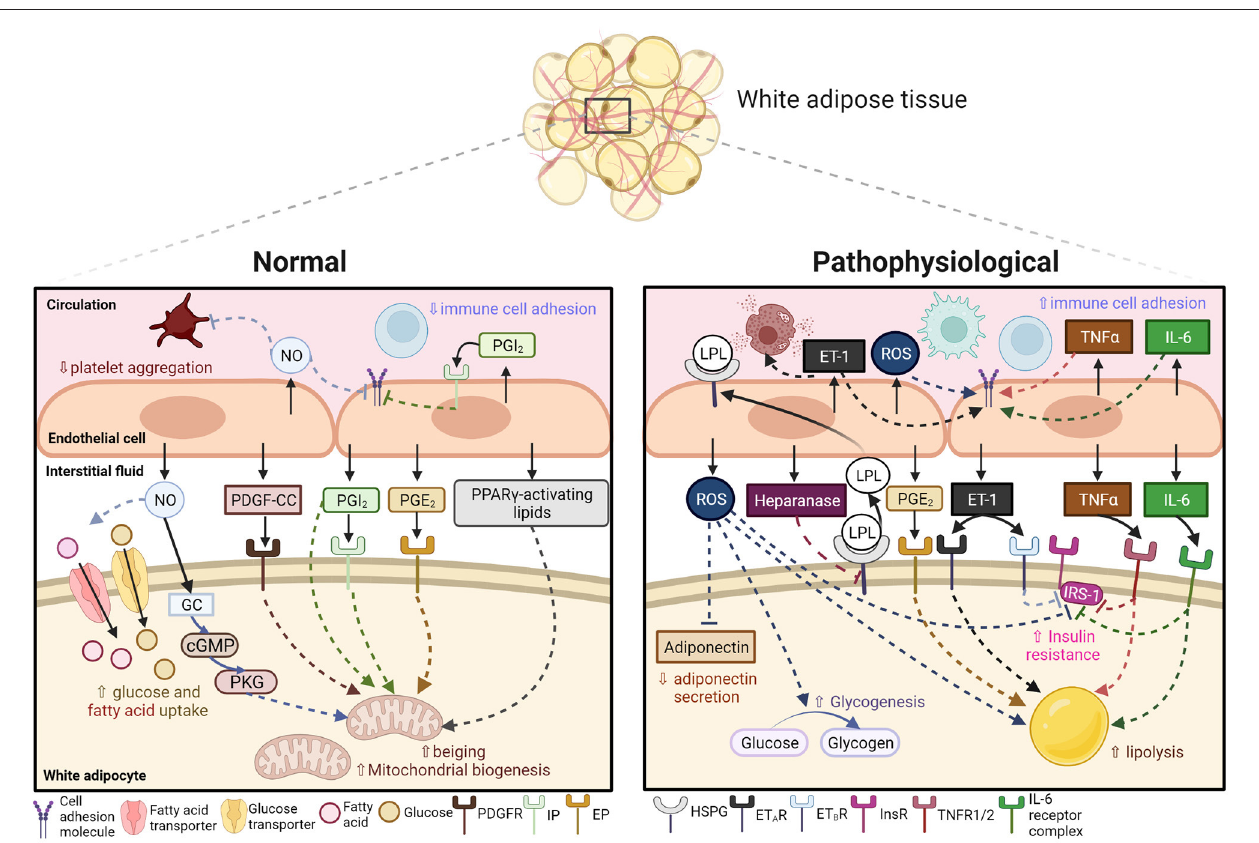
FIGURE 1 | Endothelial-derived signals in mediating AT metabolism and inflammation under normal and pathophysiological conditions in CMS. Under normal conditions, the adipose endothelium releases nitric oxide (NO), platelet-derived growth factor-CC (PDGF-CC), prostacyclin (PGI 2 ), prostaglandin E2 (PGE 2 ) and peroxisome proliferator-activated receptor gamma (PPAR γ )-activating lipid in response to changes in microenvironment. These biological signals then act on downstream signaling molecules (soluble guanylate cyclase, GC; cyclic guanine monophosphate, cGMP; protein kinase G, PKG) or receptors (platelet-derived growth factor receptor, PDGFR; prostacyclin receptor, IP; prostaglandin E2 receptor, EP) in neighboring white adipocytes, resulting in increased glucose and fatty acid uptake and upregulated beiging and mitochondrial biogenesis. NO and PGI 2 also act on the endothelium and circulating platelets to suppress immune cell adhesion and platelet aggregation. Under pathophysiological conditions, circulating or adipose-derived pro-inflammatory signals stimulate the endothelium to release reactive oxygen species (ROS), heparanase, endothelin-1 (ET-1), tumor necrosis factor-alpha (TNF α ) and interleukin-6 (IL-6). These signals act on downstream signaling partners (heparan sulfate proteoglycans, HSPG; endothelin receptors type A and B, ET A R and ET B R; TNF receptor 1/2, TNFR1/2; IL-6 receptor complex) to inhibit adiponectin secretion, increase endothelial expression of lipoprotein lipase (LPL), upregulate glycogenesis and lipolysis, and induce insulin resistance by inhibiting insulin receptor (InsR)-insulin receptor substrate-1 (IRS-1) signaling in white adipocytes. These signals also pose pro-inflammatory effects by increasing recruitment and activation of immune cells. Created with BioRender.com.